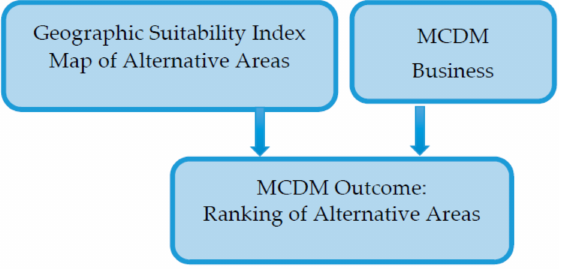
Figure 4. MCDM methodology